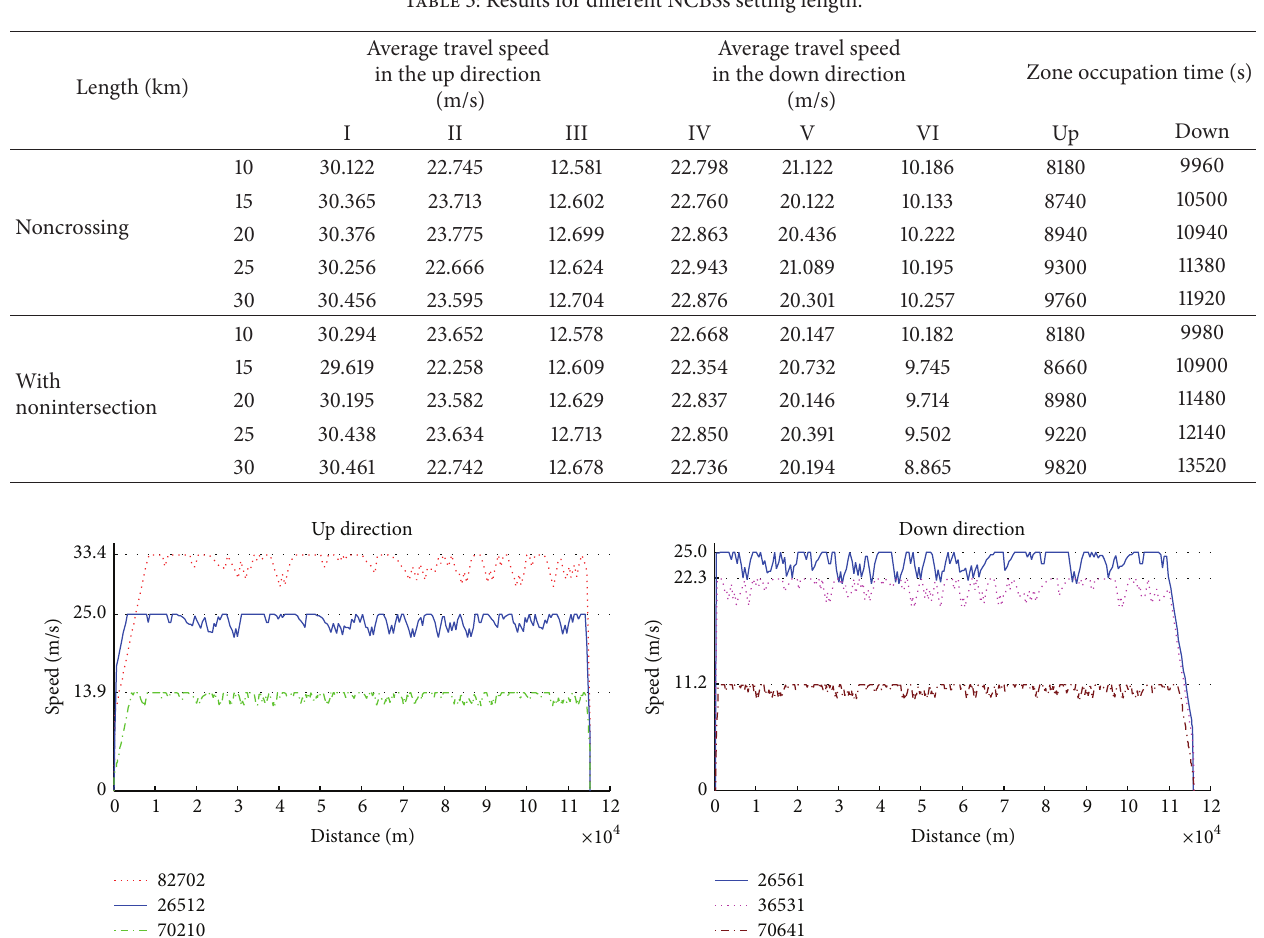
Figure 6. If the length of blocking section 3 is 30000 m without NCBS, the train speed-distance curve is shown in Figure 7. When the length of blocking section 3